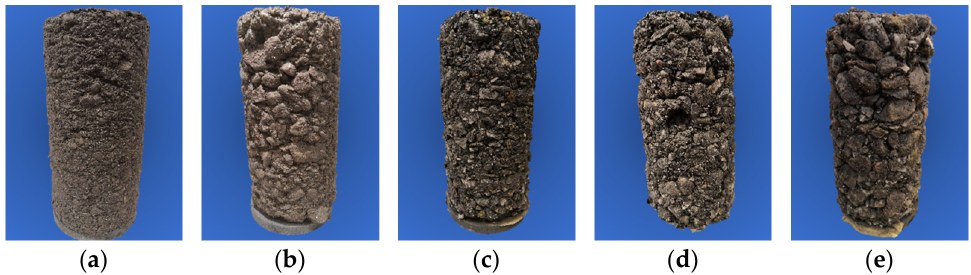
Figure 1. Pictures of unbound aggregate specimens with various gradations: ( a ) G / S = 1.0; ( b ) G / S = 1.6; ( c ) G / S = 1.8; ( d ) G / S = 2.0; ( e ) G / S = 2.5.